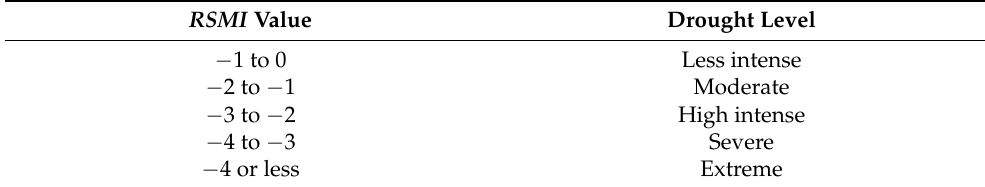
Table 1. Drought categories of the RSMI